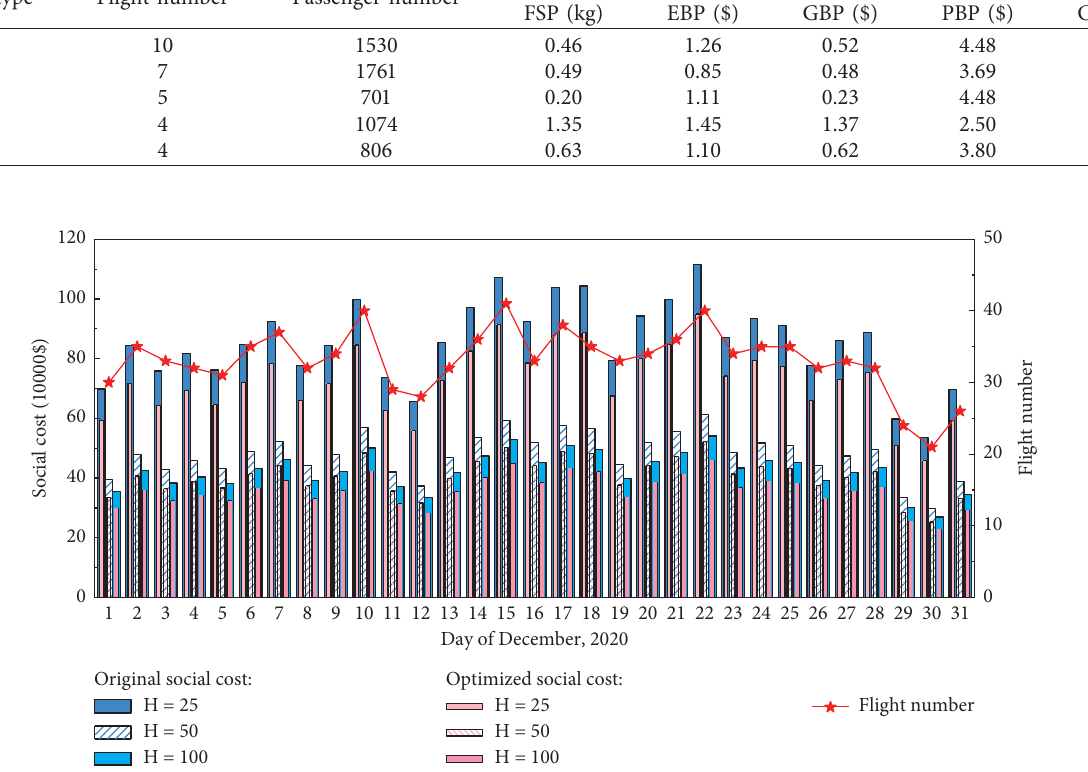
Figure 6: Flight number on route ZBAA-ZSSS and comparison of social cost with different time horizons on all days of December 2020.